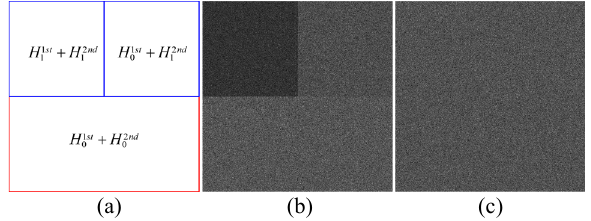
Figure 1 . The simulation frame and the real components of the simulated SAR image pair.